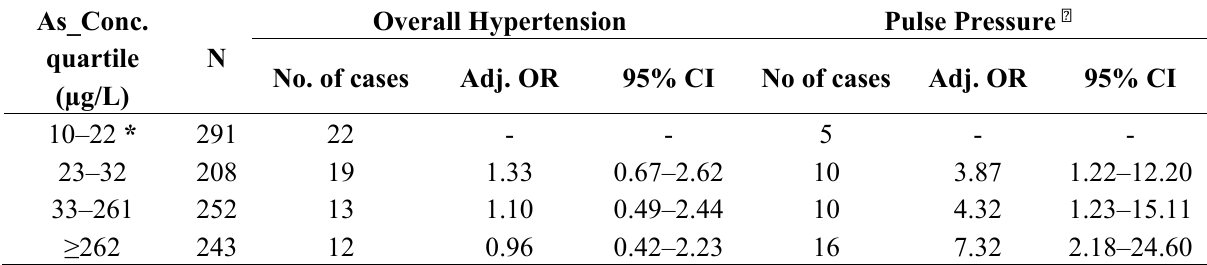
Table 3. Association of overall hypertension and increased pulse pressure to that of arsenic concentration by quartiles (n =